Question: Provide a one-line summary of what is displayed.
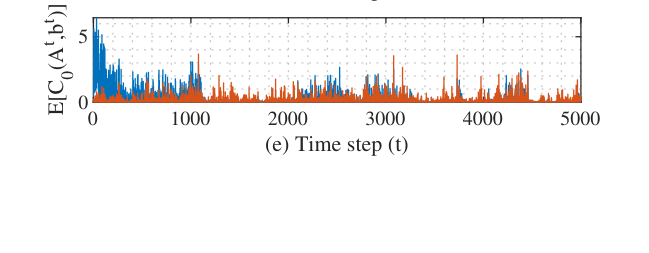
Answer: (a) The regret of both methods. (b) The Euclidean distance between two consecutive probability distributions produced by Algorithm 1, (c) the corresponding reservation const (E[C(At, Bt)]), and (d) the blocking cost (E[C0(At, Bt)]) .